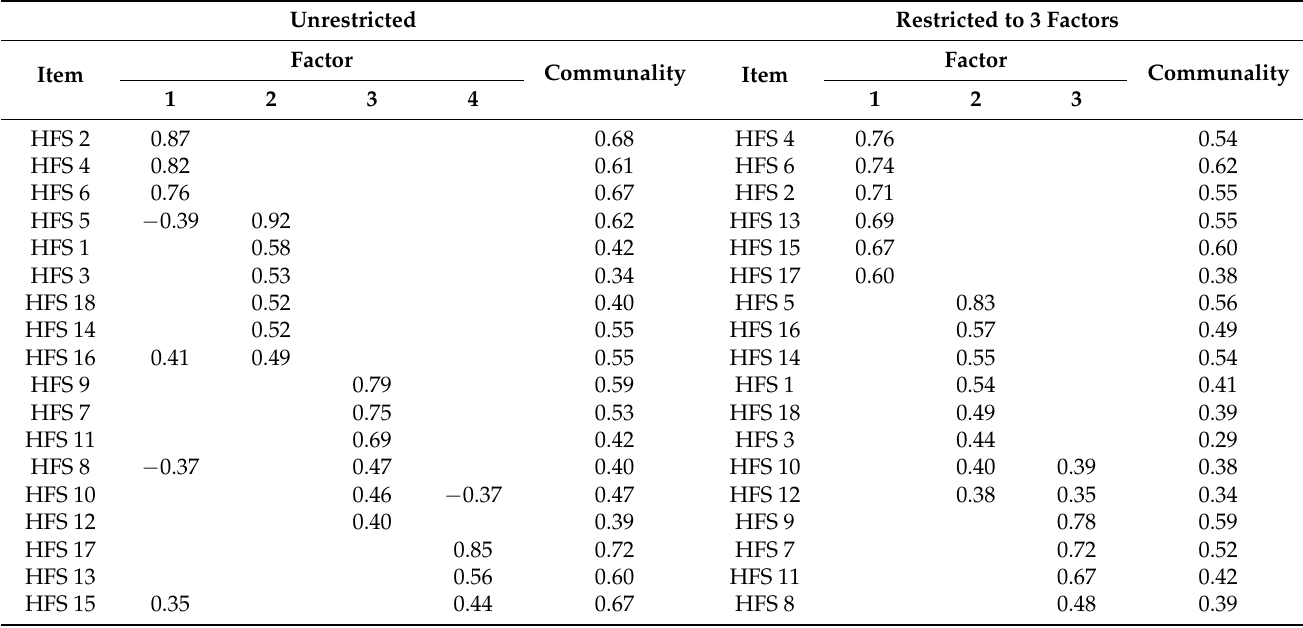
Table 2. Rotated factor matrix of the HFS with restricted and unrestricted solutions in the pilot study ( n = 203). Unrestricted Restricted to 3 Factors Factor Factor Communality Item Item